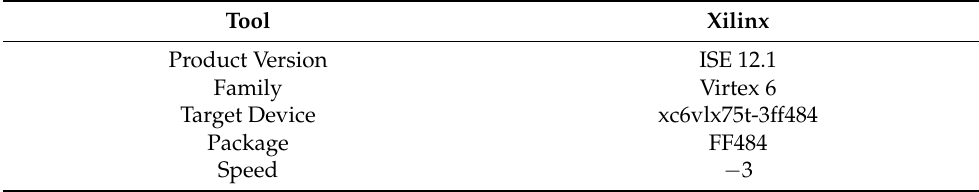
Table 4. Design Specifications on FPGA.